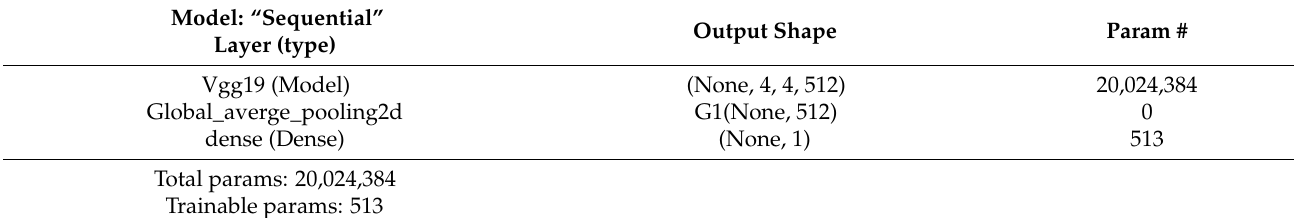
Table 7. Trainable and non-trainable parameters. Model: “sequential”.